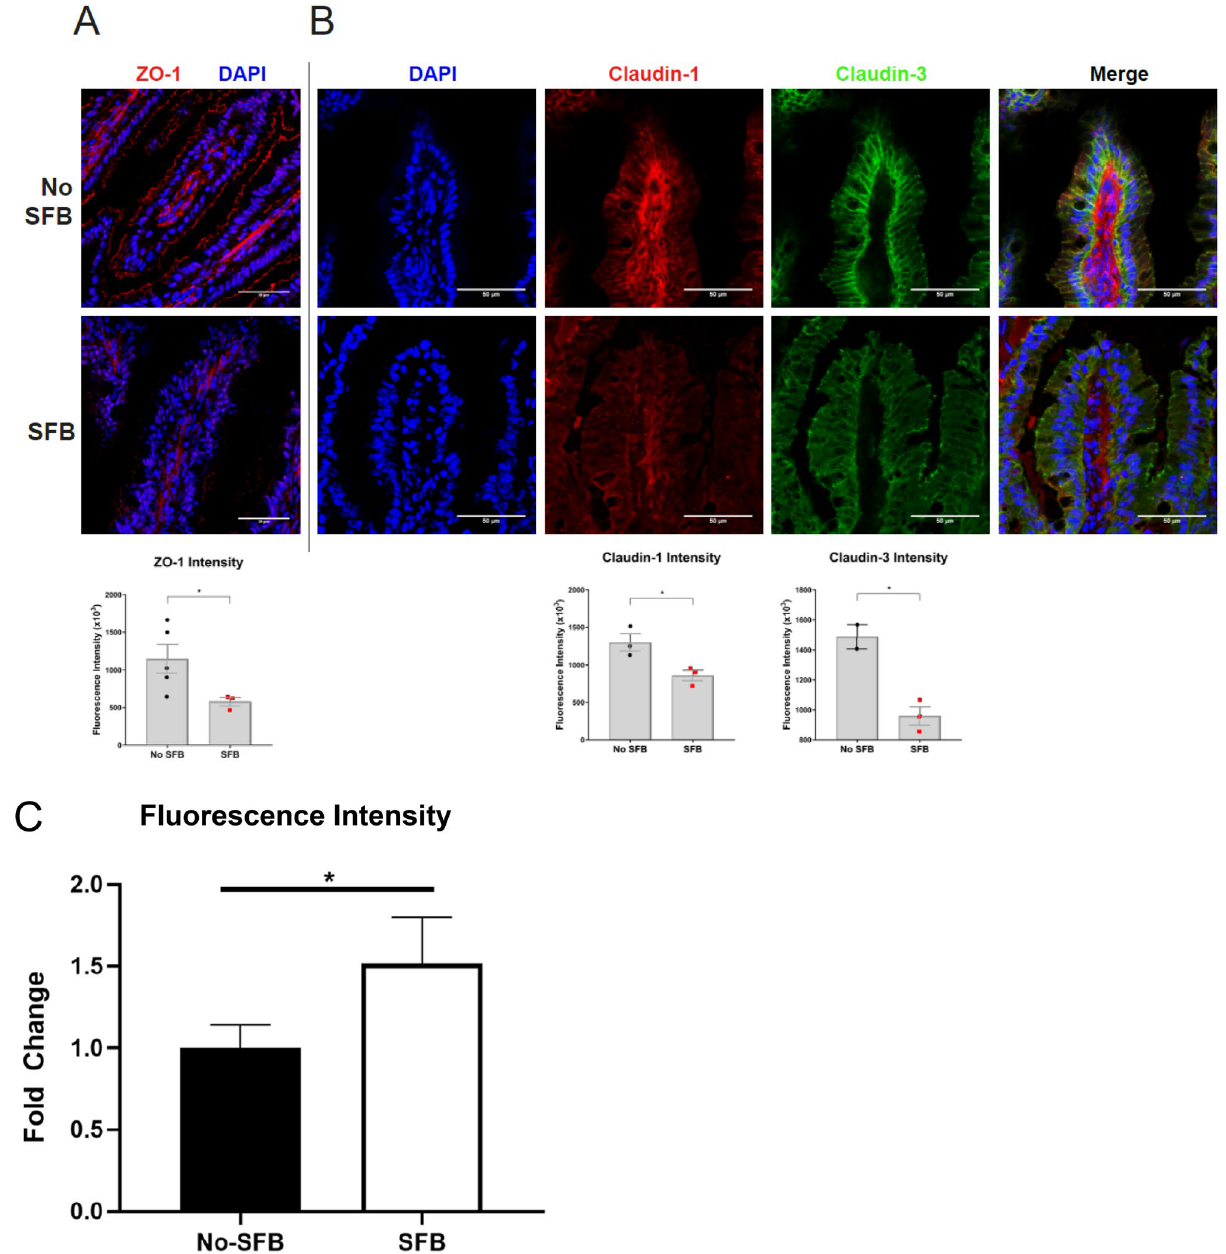
Figure 4. Small intestinal tight junctions are reduced in SFB colonized NZM2410 mice. ( A ) ZO-1 tight junction scaffolding protein (red) is decreased in +SFB mice at 30 weeks of age. ( B ) Claudin-1 (bottom panels; red) and Claudin-3 (bottom panels; green) tight junctions were also decreased in +SFB mice at the same time point. Standardized fluorescence intensity analyses are shown below. C. Intestinal permeability is increased in SFB-colonized mice as measured by Dextran-FITC fluorescence. Error bars represent mean ± SEM ( A – C ). Unpaired Student t test ( A – C ). * p <